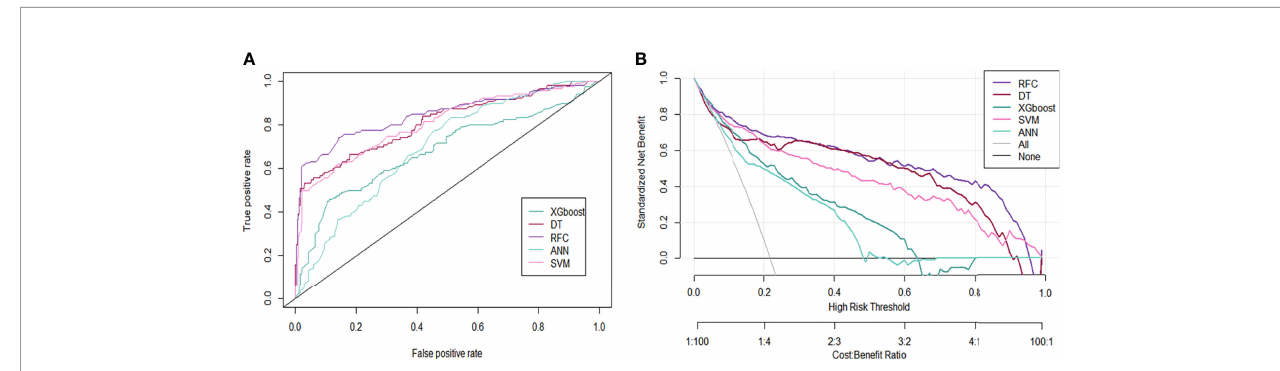
FIGURE 4 | Predictive performance of candidate models based on the ML-based algorithm. (A) Area under the ROC curve for 5 ML-based models. (B) DCA for the 5 ML-based models. ANN, arti fi cial neural network; DT, decision tree; RFC, random forest classi fi er; SVM, support vector machine; XGboost, eXtreme gradient